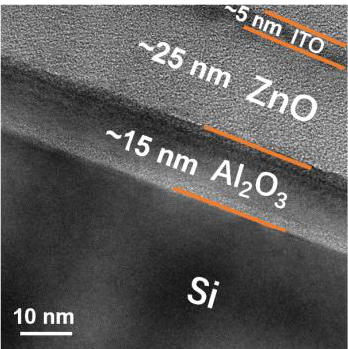
Figure 5. Cross-sectional TEM image of the Al 2 O 3 /ZnO/ITO film. Al 2 O 3 /ZnO/ITO film was deposited on Si substrate.